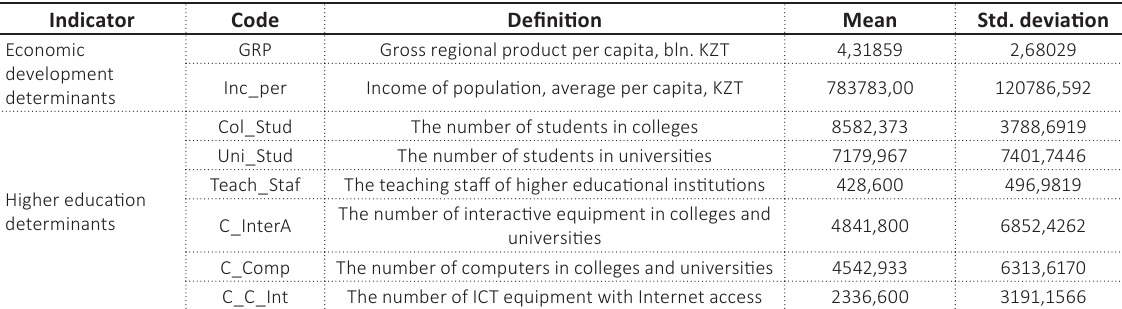
Table 1. Selected measurement variables used in the correlation